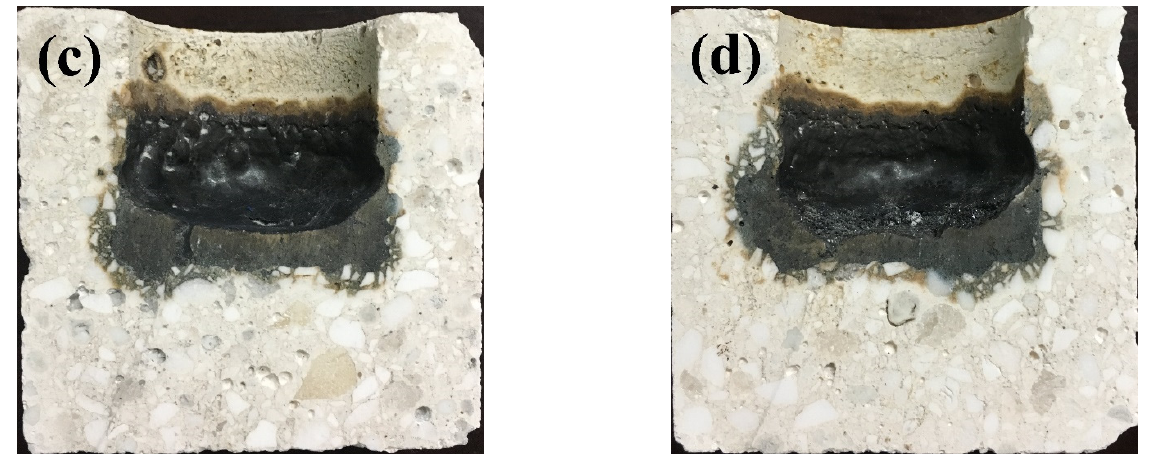
Figure 4. Corroded specimens after the corrosion test: ( a )-Ref., ( b )-A, ( c )-B and ( d )-C.